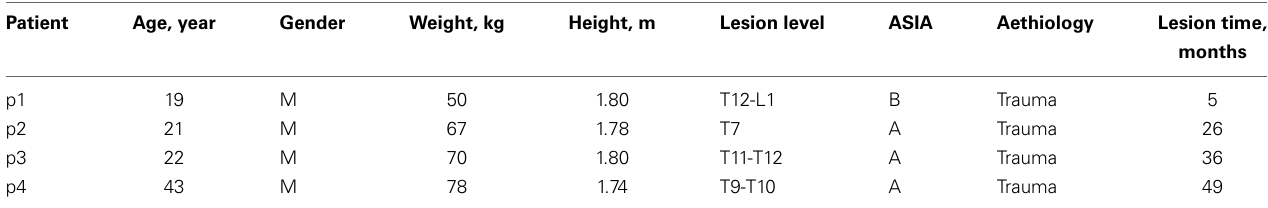
Table 1 | Subject